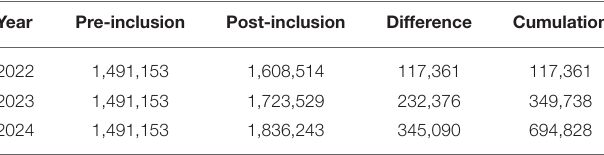
TABLE 10 | Total medical insurance payments of FosAPR before and after inclusion